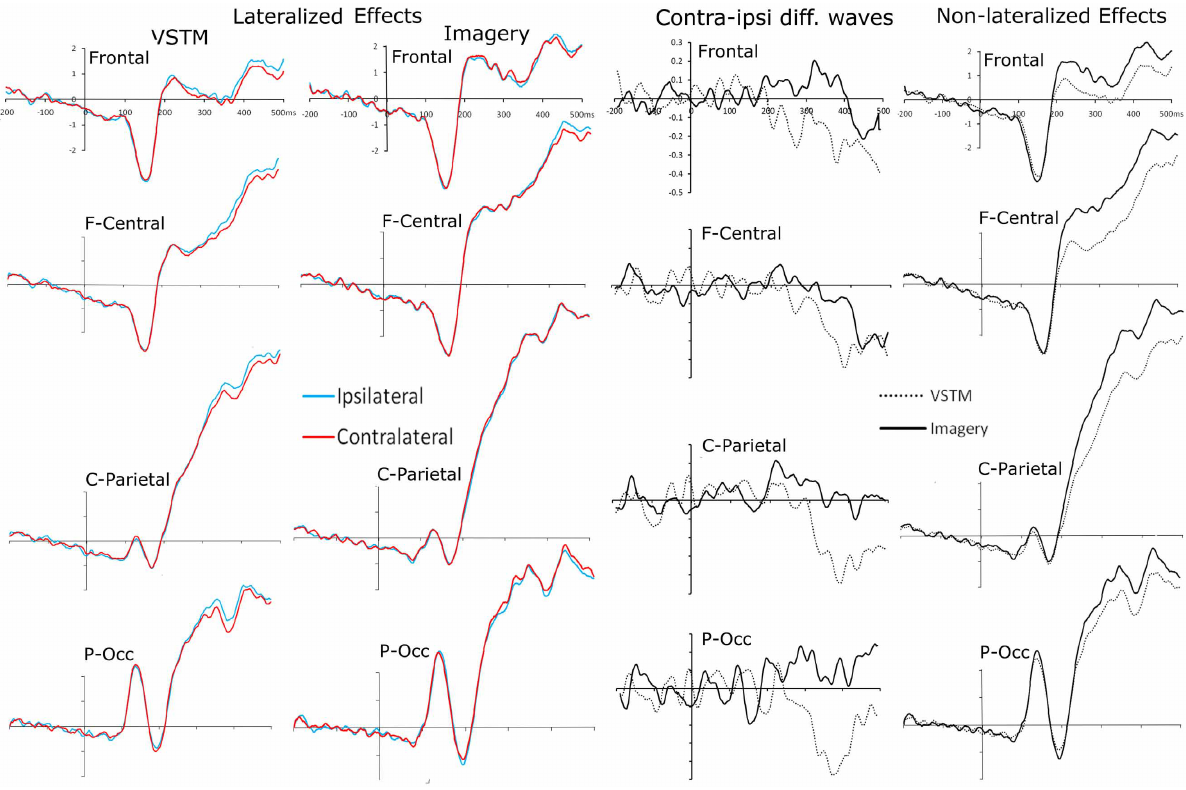
FIGURE 4 | Probe-locked waveforms for each of the four electrode clusters (Frontal, Fronto-Central, Centro-Parietal, Parieto-Occipital). The left hand column shows the comparison of recordings taken ipsilateral and contralateral to the remembered location of the centrally presented probe shape. The middle-left column shows the comparison of recordings taken ipsilateral and contralateral to the